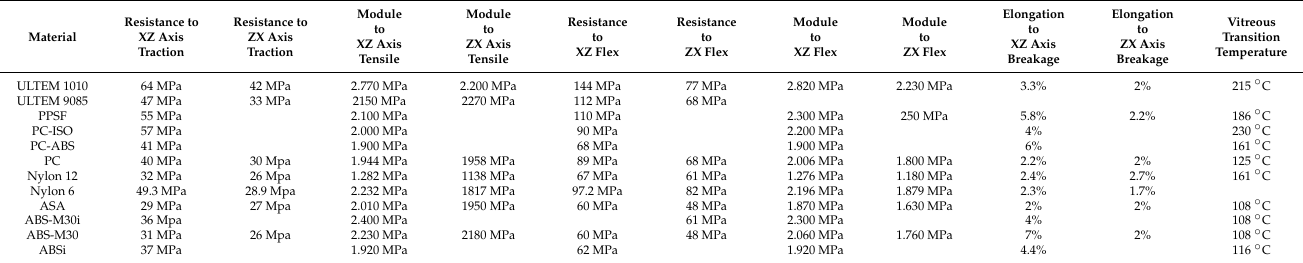
Table 1. Mechanical properties of different commercial materials,